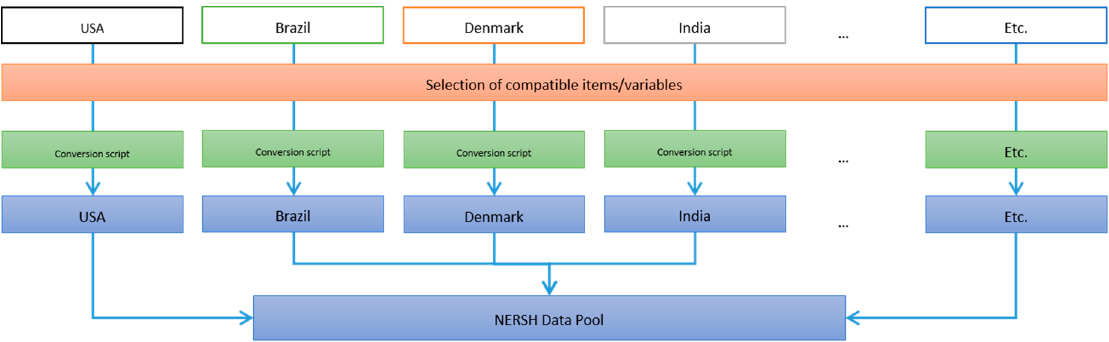
Figure 1. Overview of data conversion strategy.